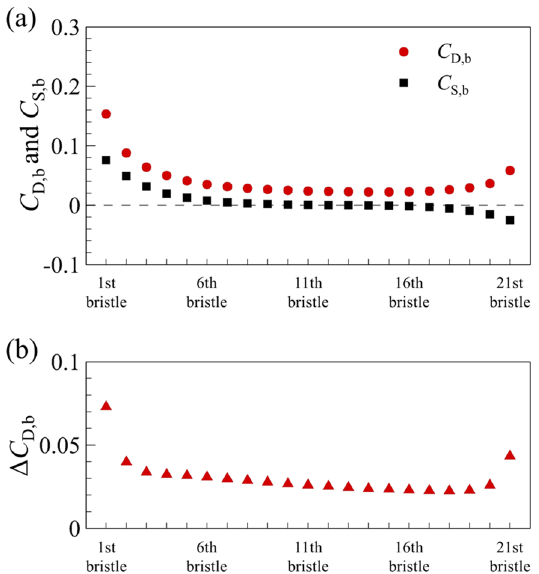
Figure 12. ( a ) The drag coefficient ( C D,b ) and side force coefficient ( C S,b ) on each bristle of the upper one of the two bristled wings. ( b ) The relative change in C D,b on each bristle (Δ C D,b ) between single bristled wing and the right wing of two bristled